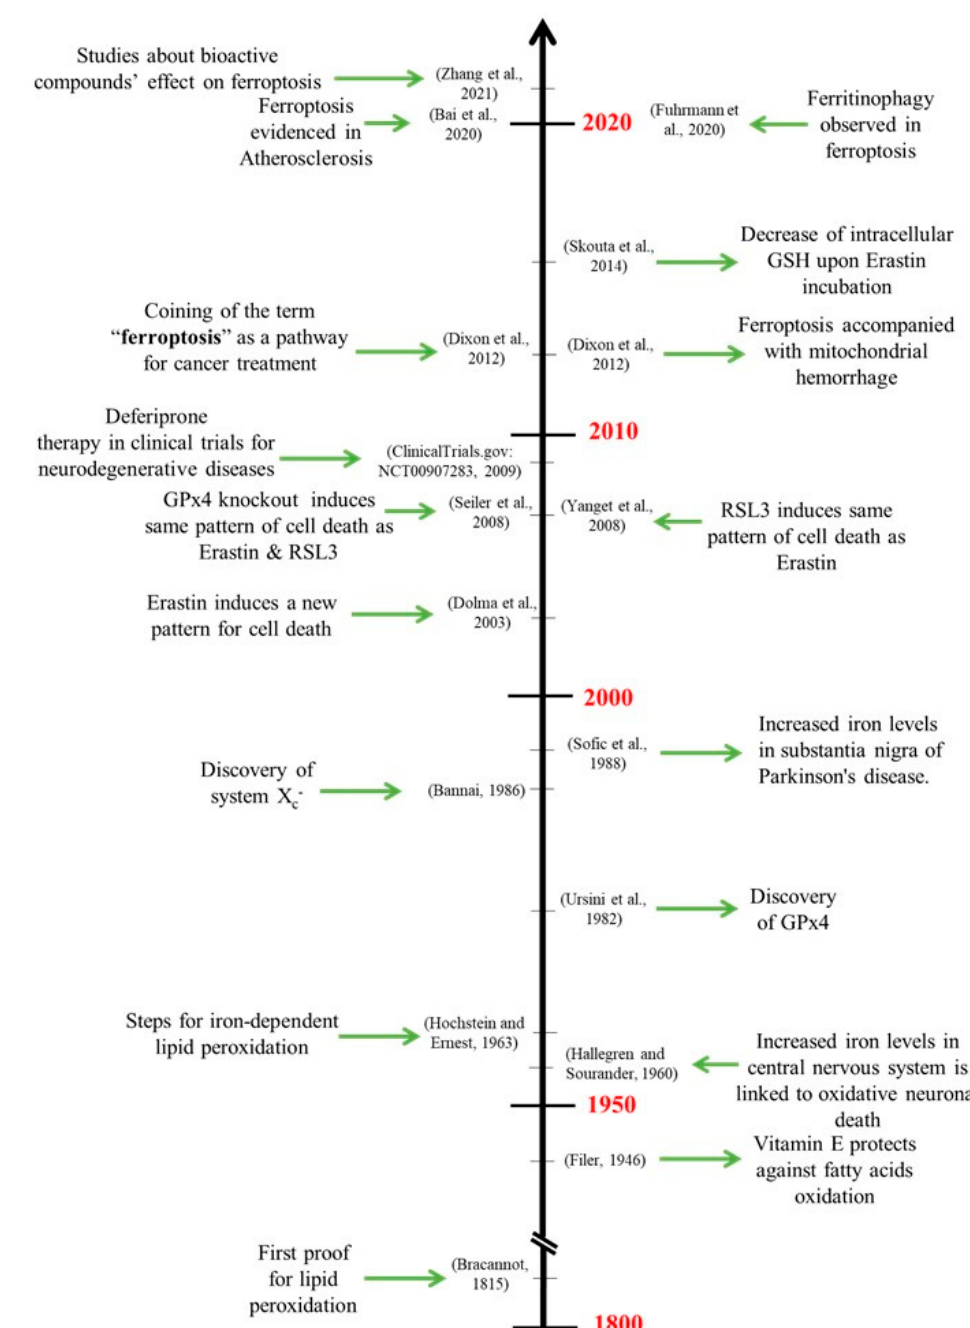
Figure 1. Timeline of the major discoveries concerning ferroptosis .